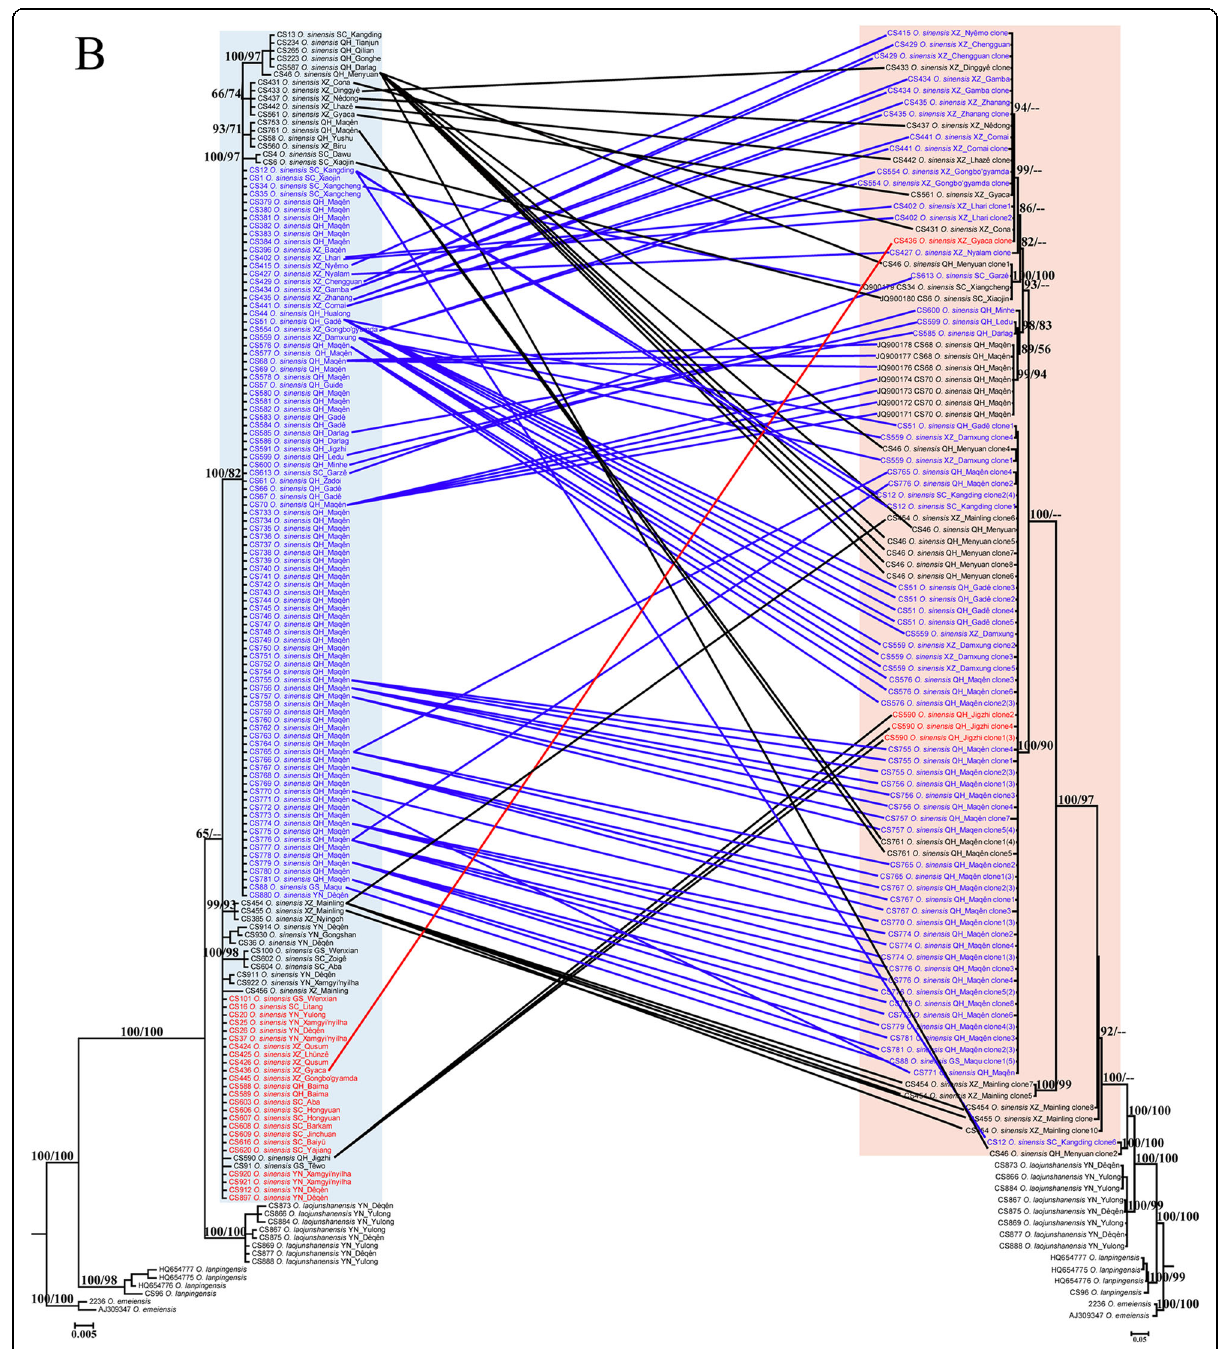
Fig. 2 Bayesian phylogenetic consensus tree inferred from the combined dataset ( a ) and the ITS functional and pseudogenic sequences separately (left and right part of b respectively). The numbers above branches are Bayesian posterior probabilities (left) shown as percentages and bootstrap values (right) calculated from the ML analysis of 1000 sequence replicates. Sequences in light blue and dark pink boxes represent functional ITS sequences and pseudogenes, respectively. Numbers in brackets indicate duplicated clones. Functional and pseudogenic sequences from the same individuals are connected with straight lines. Taxa in blue are individuals with the dominant ITS haplotype (haplotype2) and those in red individuals which share the same ITS haplotype (haplotype1) with the planned epitype